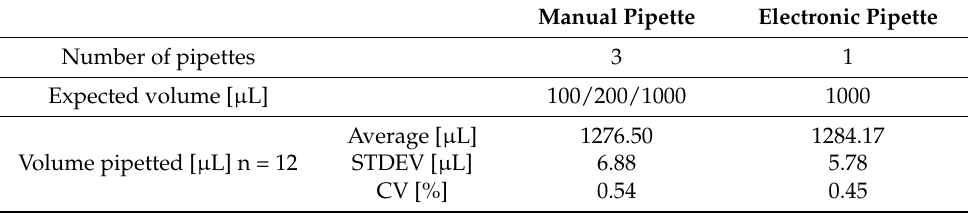
Table 8. Measurement results of pipetting 100 µ L using manual and electronic